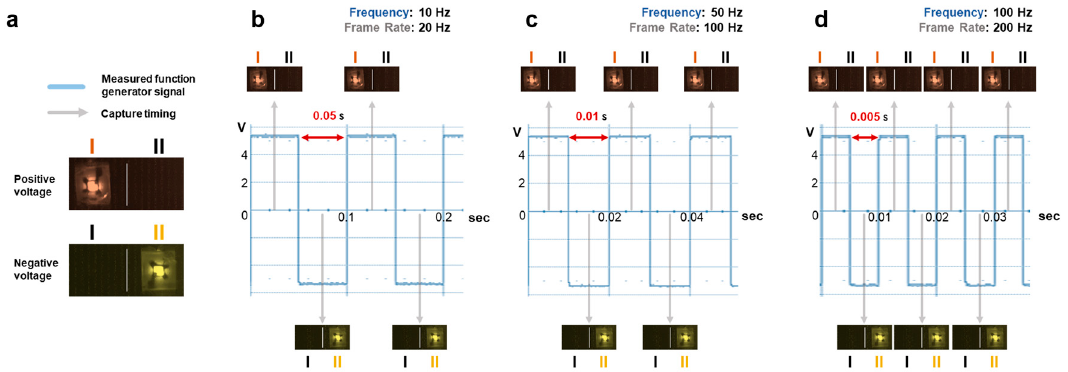
Figure 3. To confirm synchronization of the automatic system for DFS by using an LED circuit: ( a ) the LED circuit is operated by an input voltage applied to the function generator: the red LED (left LED) is at a positive voltage, and the yellow LED (right LED) is at a negative voltage. ( b – d ) The comparison between the applied signal with different frequencies and the captured images with the frame rates corresponding to the frequencies of the signal; ( b ) 10 Hz versus 20 frame/s, ( c ) 50 Hz versus 100 frame/s, and ( d ) 100 Hz versus 200 frame/s, where the amplitude of the applied signal was 10 V peak-to-peak .